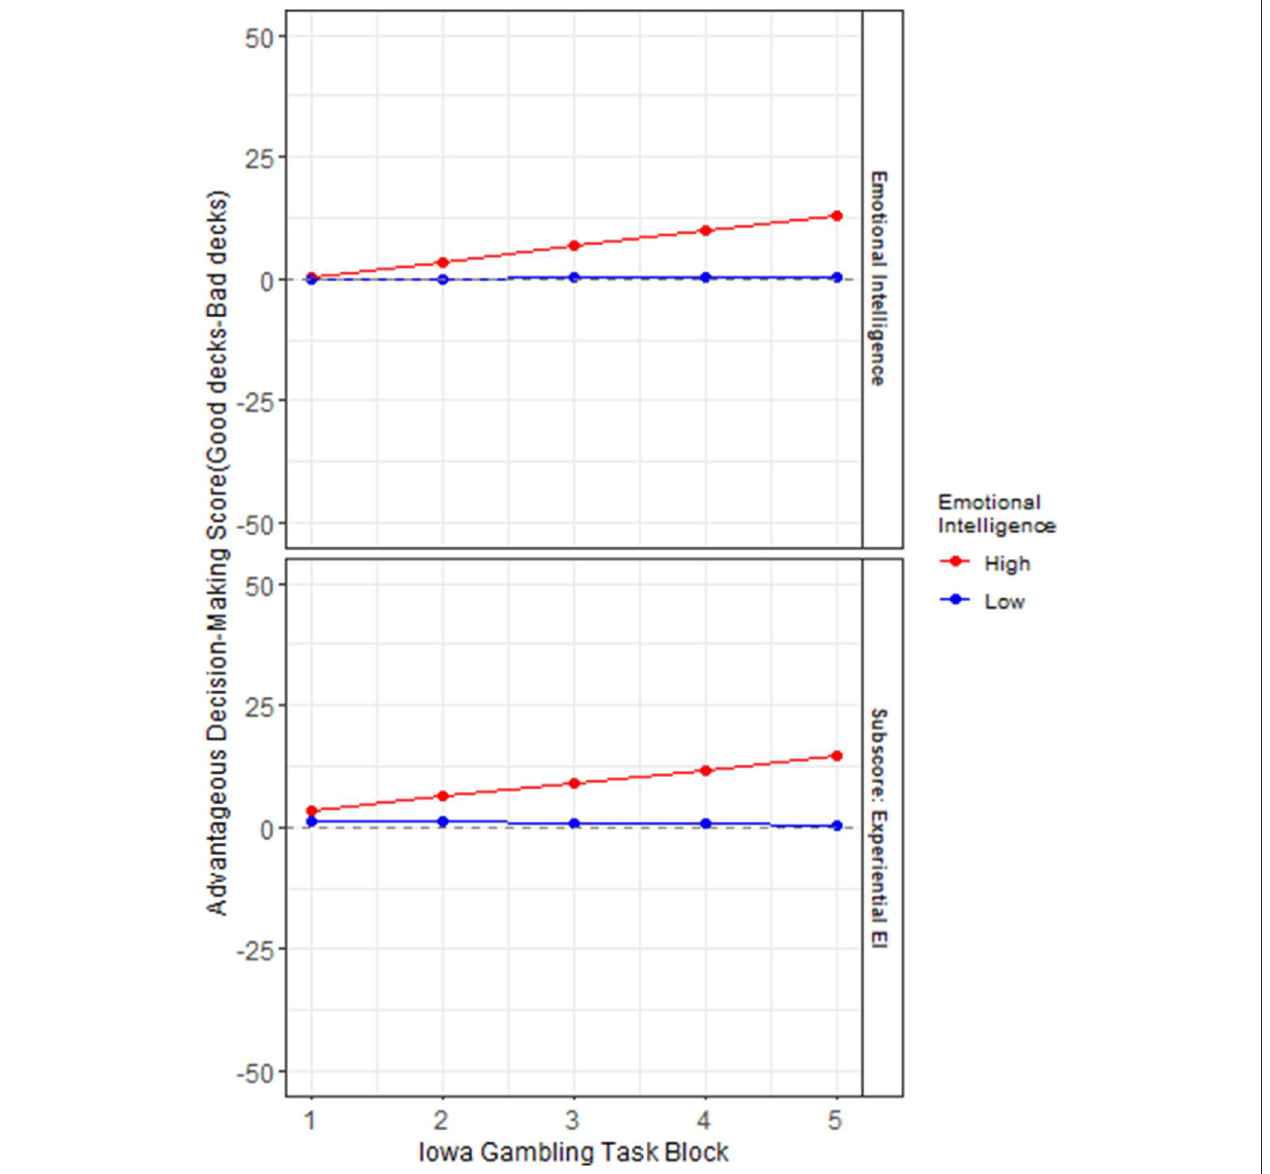
FIGURE 1 | Role of emotional intelligence in rate of learning on the Iowa Gambling Task: The y axes represent advantageous decision-making on the Iowa Gambling Task (IGT), calculated as the number of picks from the bad decks subtracted from the number of picks from the good decks. The x axes represent the progression of the task across trials in 5 blocks (of 20 trials each) from the start to the end of the task. A median split separates high (red) and low (blue) scores on index score of emotional intelligence (EI), and its area sub-score Experiential Emotional Intelligence